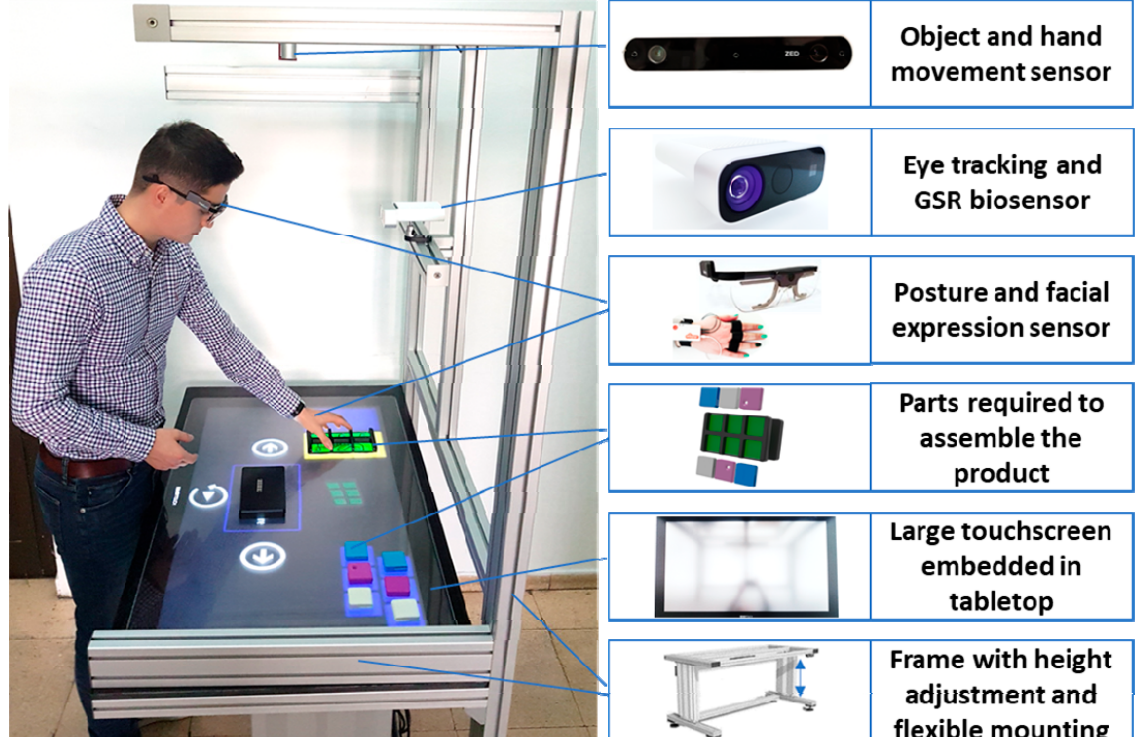
Figure 1. Assembly assistance system.